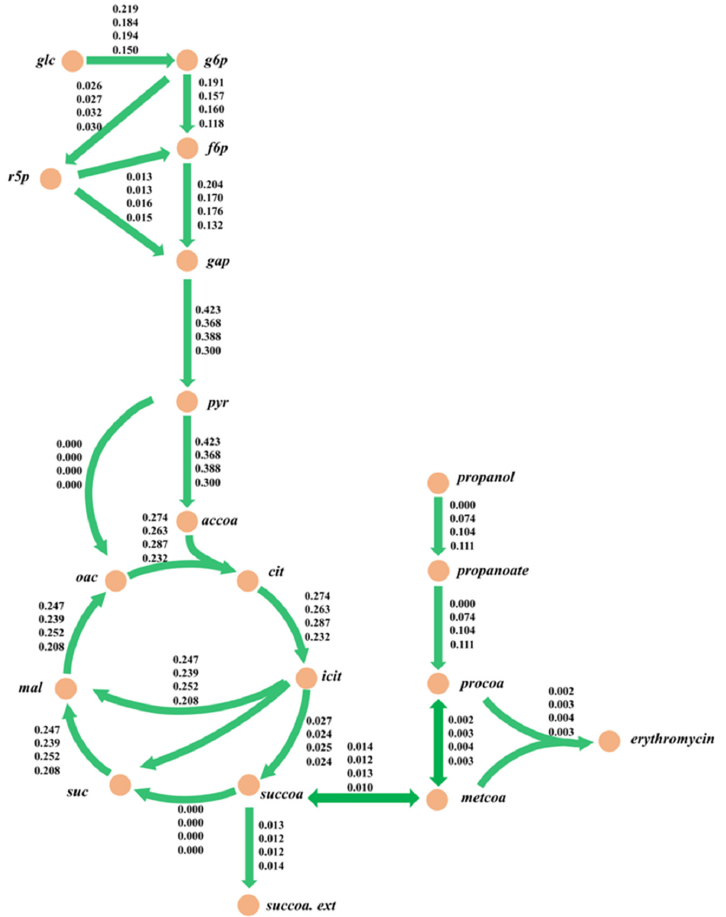
Figure 6. Metabolic flux analysis of each mode for the engineered strain E3- ∆ suc C during 96–108